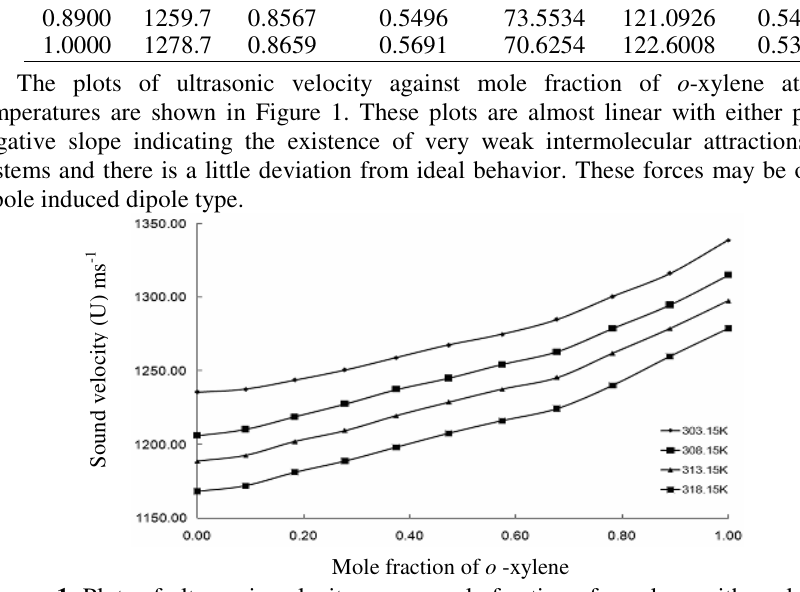
Figure 1. Plots of ultrasonic velocity versus mole fraction of o -xylene with cyclohexane at different temperatures.